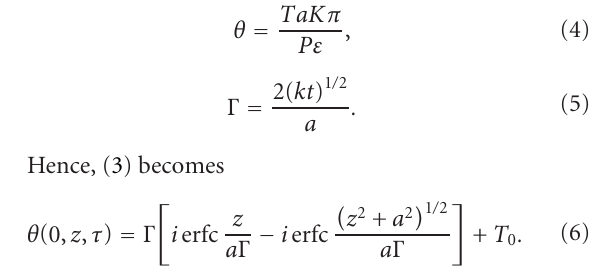
Figure 3: The designed